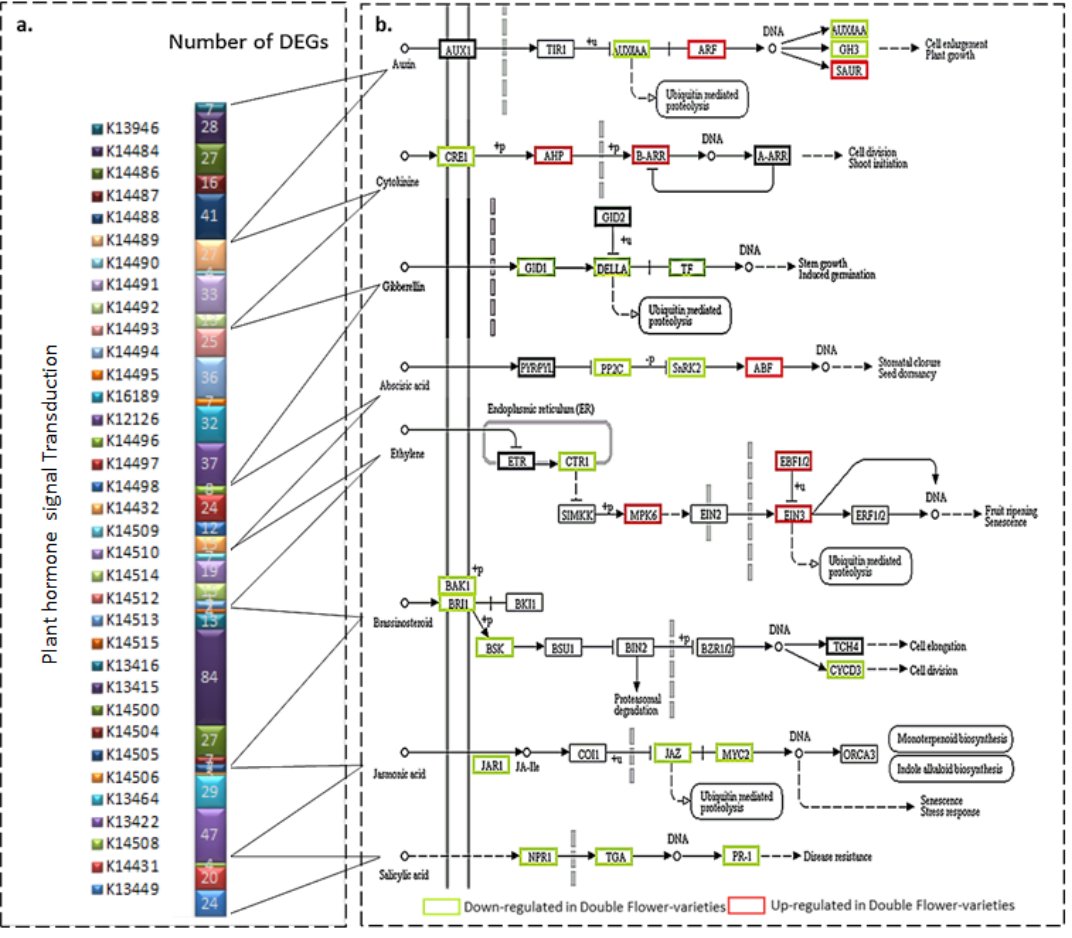
Figure 7. Identification of differential analysis of the hormonal network between single and double flowered species of apple. ( a ) The number of DEGs encoding the key components involved in various hormonal signaling pathways. ( b ) Overview of various hormonal signaling network in apple. Green indicated the single flower predominantly expressed genes and red indicated the double flower predominantly expressed genes.